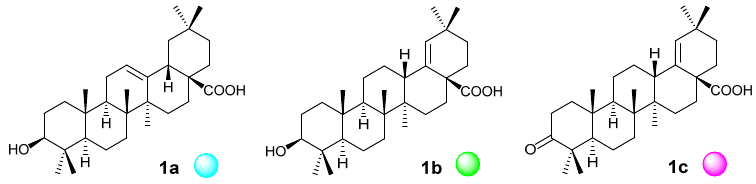
Figure 1. Structures of oleanolic acid ( 1a ), morolic acid ( 1b ), and moronic acid ( 1c ).